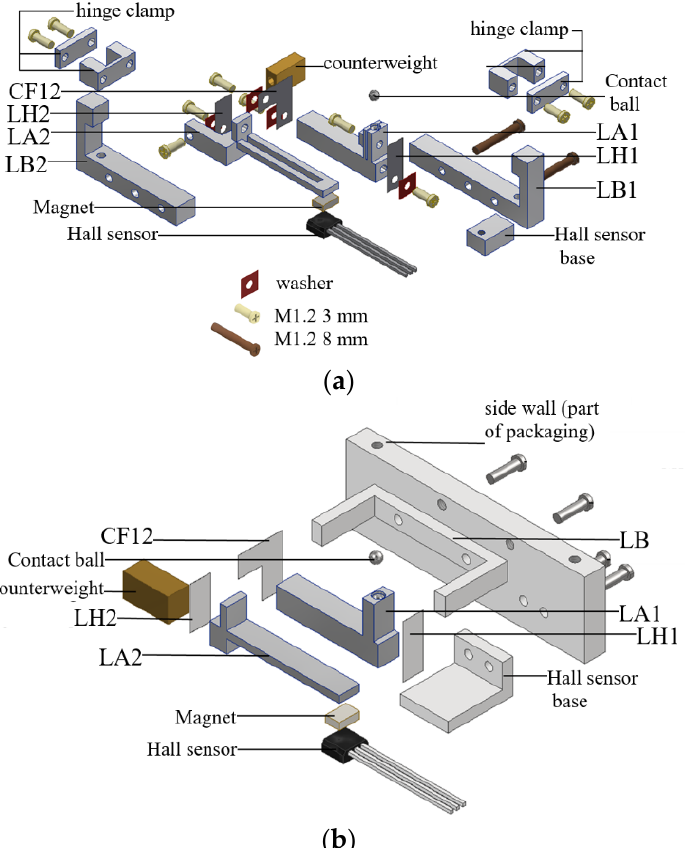
Figure 36. Design modification of the Alpha Model (excluding the packaging and the CRM) for small lot size production; ( a ) current Alpha Model and ( b ) after modification and simplification.